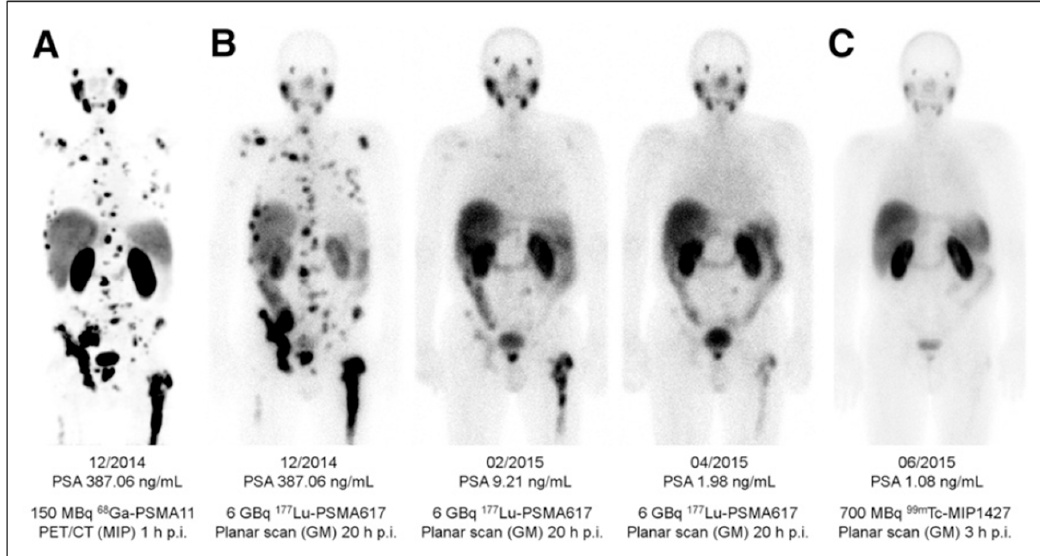
Figure 9. ( A ) Pre-therapeutic imaging using [ 68 Ga]Ga-PSMA-11 PET/CT delivering highest resolution; ( B ) Co-emission of γ -rays by Lu-177 enables imaging during therapy with [ 177 Lu]Lu-PSMA-617; ( C ) 99m Tc-PSMA scintigraphy has minimally less noise than posttherapy scanning and can be used for imaging follow-up in out-patient setting. GM 5 geometric mean; MIP 5 maximum-intensity projections; p.i. 5 after injection. Reproduced from [132].